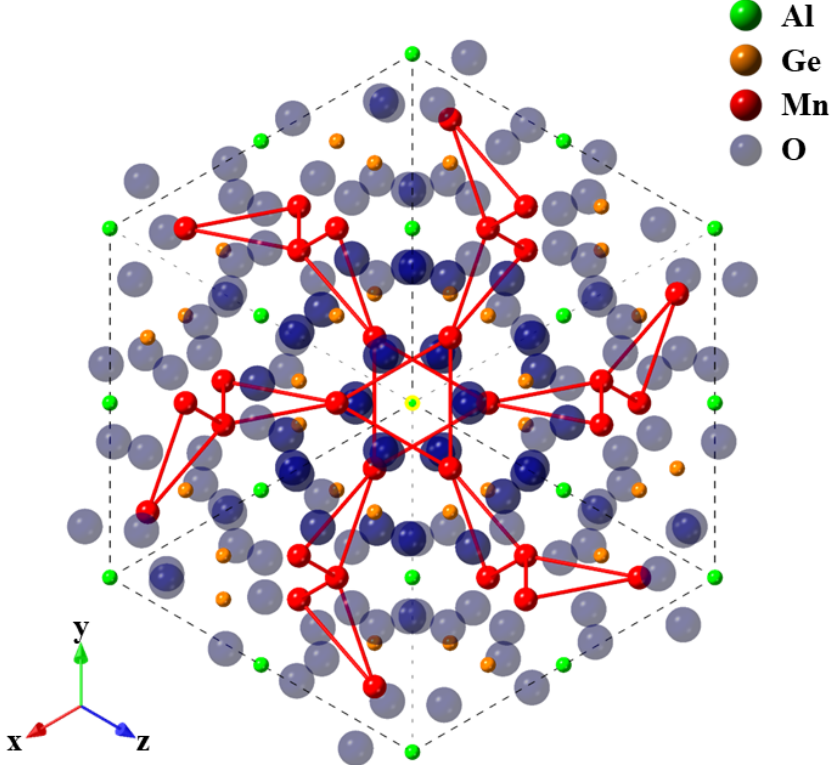
Figure 1. Crystal structure of Mn 3 Al 2 Ge 3 O 12 . The Mn-Mn “bonds” highlighted in red emphasize the formation of a hyperkagomé structure. The cubic unit cell is viewed along the [111] direction and outlined using black dashed